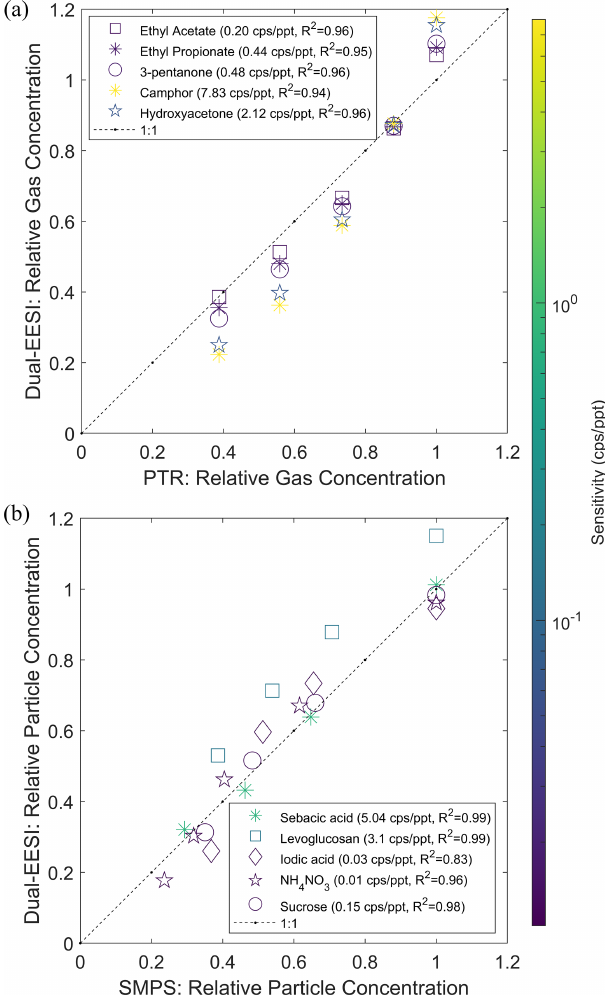
Figure 3. Dual-EESI linearity for chemical standards that span al- most 10 orders of magnitudes in the estimated saturation vapor con- centration. (a) Measured intensity of different gaseous species (TP– PP) and (b) particulate species (PP–FP 2 ) with estimated saturation vapor concentrations > 102µgm − 3 . The gaseous species were gen- erated by a Vaporjet and quantified by a PTR (see Figs. S9 and S14). The particulate species were generated by a nebulizer and quanti- fied by an SMPS using the effective density of the chemical stan- dard. Color scales indicate the sensitivity (cpsppt − 1 ) in the gas and particle phase as indicated in the respective legend. Each set of cali- bration data points is fitted by a linear regression p 1 · x . For display, the y -axis data points are then normalized by the maximum of the regressed data points using the x -axis data